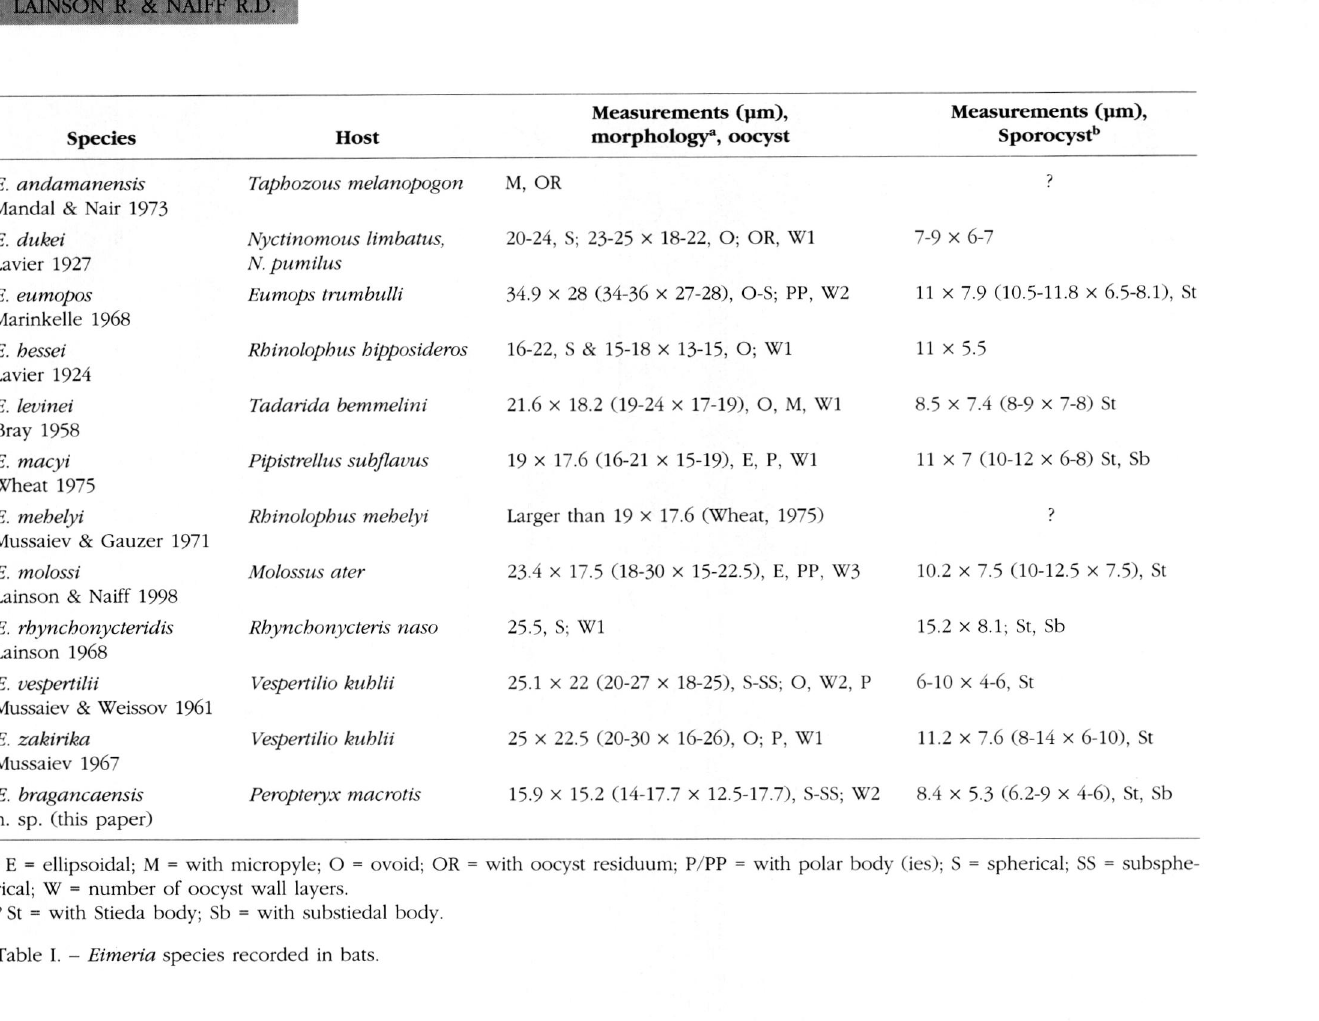
Table I. - Eimeria species recorded in bats.